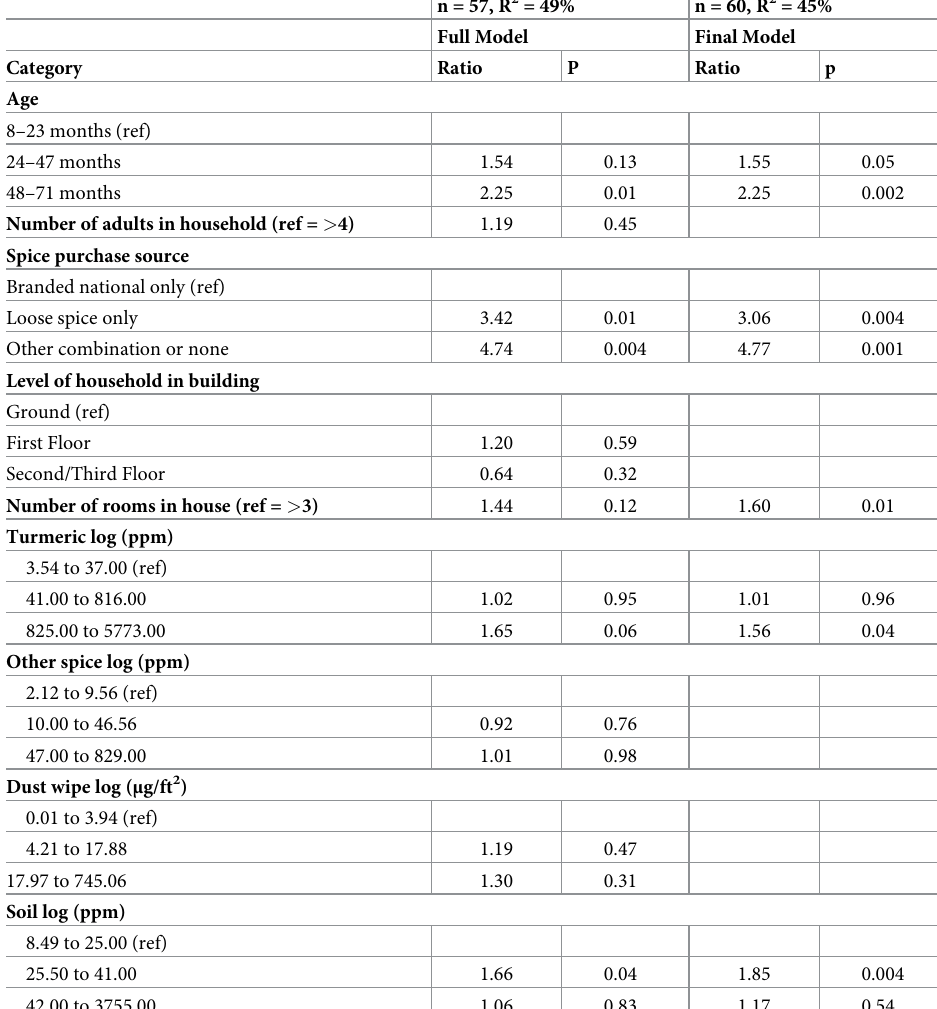
Table 13. Backward models Of BLLs and variables significant at p < 0.10, categorical age forced into the model with R-Squared Distal group Patna Bihar, 2020. n = 57, R 2 =